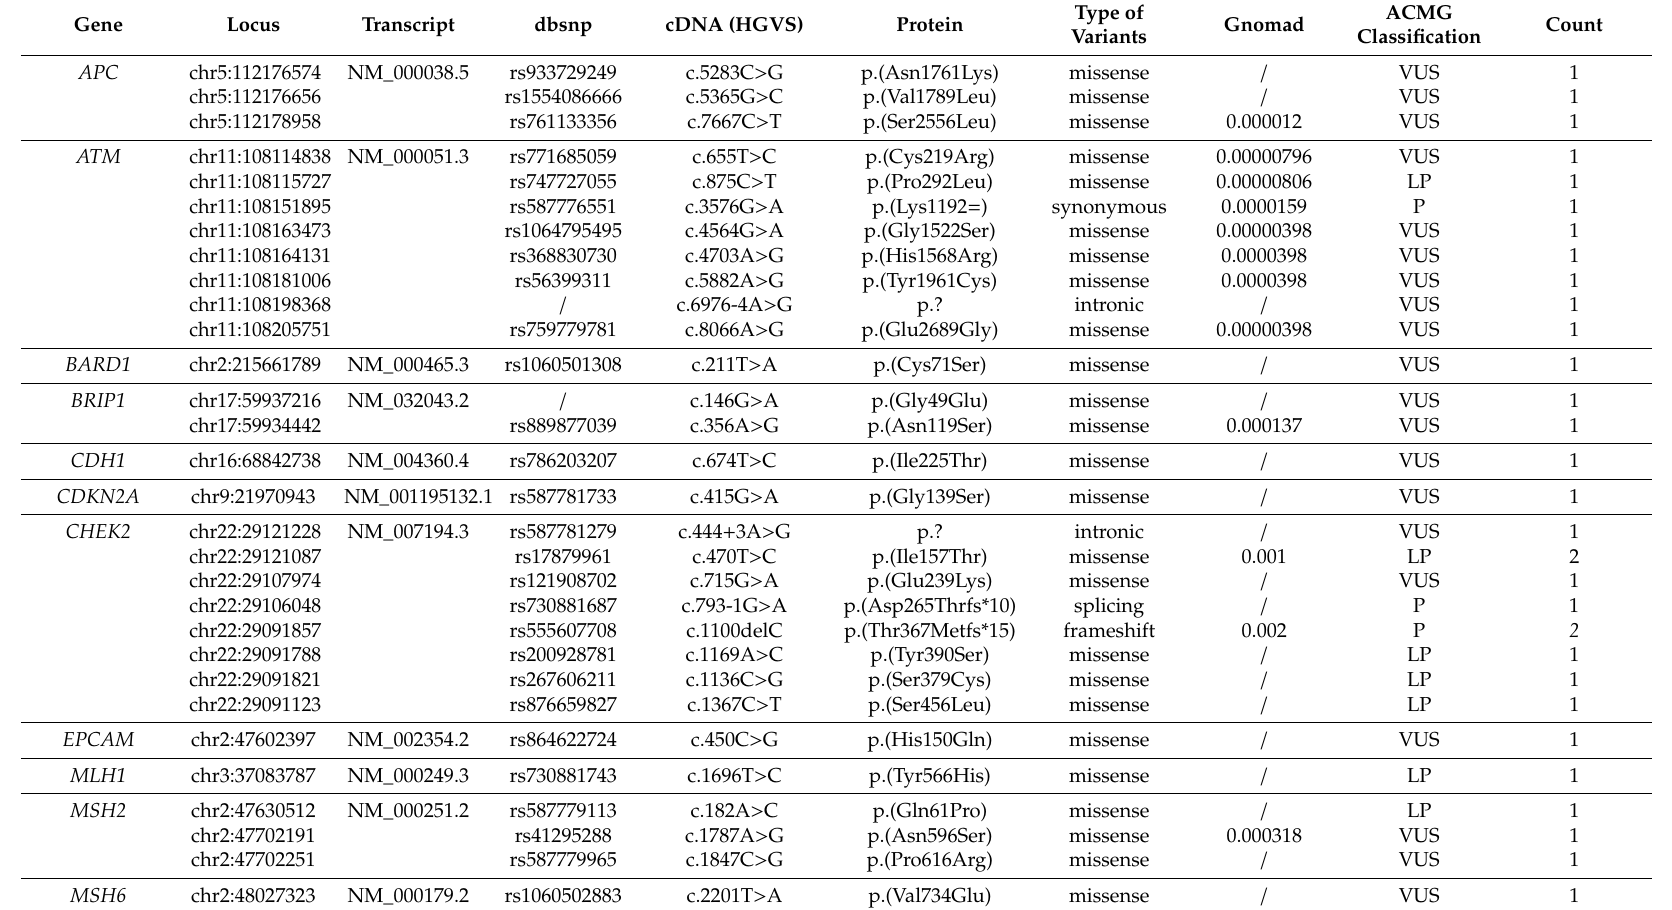
Table 3. P / LP and VUS gene variants detected in the